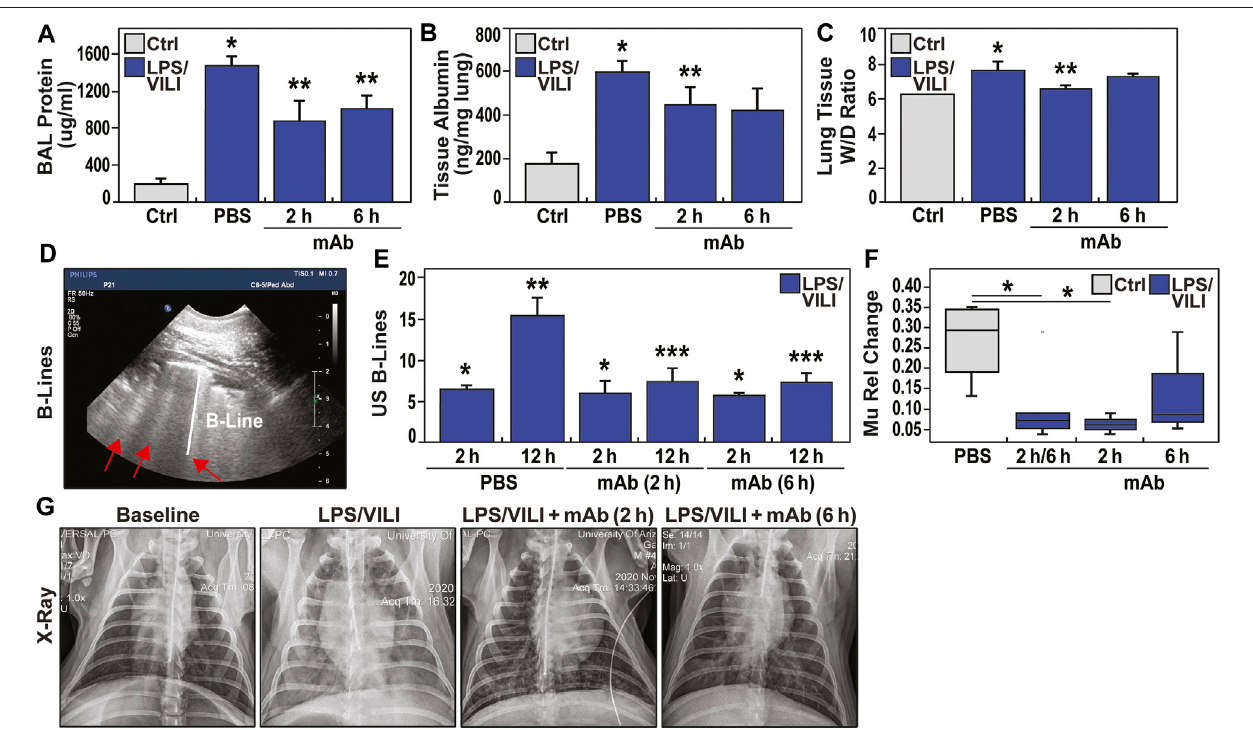
FIGURE 3 | eNAMPT ALT-100 mAb attenuates lung edema formation in LPS/VILI porcine model. (A,B) LPS/VILI-exposed minipigs exhibit signi fi cantly increased levelsofBALtotalproteinandlungtissuealbuminlevelsat12 hconsistentwithlungvascularandepithelialbarrierdysfunction.MinipigsreceivingALT-100mAb ateither 2 h or 6 h demonstrated signi fi cant reductions in BAL protein and lung tissue albumin. * p < 0.05 control vs. untreated LPS/VILI; ** p < 0.05 mAb LPS/VILI vs. untreated LPS/VILI. (C) Lung tissue wet/dry (W/D) weight ratios were calculated to quantify the level of lung edema and fl uid accumulation as we previously described (Bermudez et al., 2022). These studies revealed signi fi cant W/D weight ratio increases in LPS/VILI-challenged pigs compared to control group which were signi fi cantly reduced in pigs receiving ALT-100 mAb at 2 h with pigs treated at 6 h trending toward signi fi cant reductions (7.22 ± 0.14 vs. 7.82 ± 0.43, p = 0.1). (D,E) Ultrasound- based measurements (4 lung quadrants) of the average number of B lines, a re fl ection of lung water/edema, were obtained. B lines were completely absent at baseline (not shown) but prominently increased in all 3 treatment groups (PBS, mAb 2h, mAb 6 h)after 2 h ofLPS/VILIexposure,further increasingwhen assessed at 12 h. Pigs treated with ALT-100 mAb (0.4 mg/kg) at either 2 h or 6 h post onset of injury, showed marked reductions in B lines at 12 h compared to the PBS-treated group (* p < 0.05 vs. control, uninjured pigs; ** p < 0.05 baseline (BL) vs. 12 h endpoint in LPS/VILI-exposed pigs; *** p < 0.05 12 h mAb 2 and 12 h mAb 6 vs. 12 h PBS pigs). (F,G) Representative chest radiographs obtained at baseline (0 h, prior to LPS/VILI challenge) and after 12 h exposure to LPS/VILI with quanti fi cation of lung edema by measuringthechangeinmu1Relvalueat12 hcomparedtoitsown0 hbaseline.TherelativeCXRmu1valuesweremarkedlyelevated atthe12 hendpointinuntreated LPS/VILIpigs.In contrast, mu1valuesinthecombined ALT-100mAb treatedpigs at2and 6 h weresigni fi cantlydiminished when compared tountreated LPS/VILIpigs ( p = 0.03). This reduction remained signi fi cant when only 2 h pig mu1 values were considered ( p = 0.02). The mu1 values from ALT-100 6 hrs-treated pigs were not signi fi cantly different compared to untreated LPS/VILI pigs ( p = 0.2).